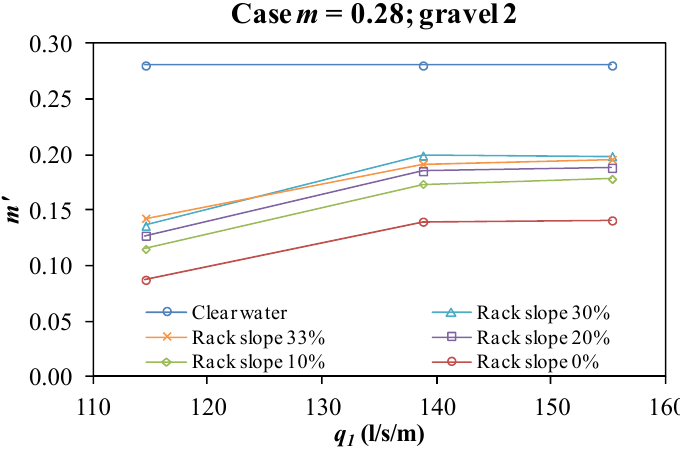
Figure 12. Effective void ratio values m' , in case of rack C ( m = 0.28) and gravel 2.